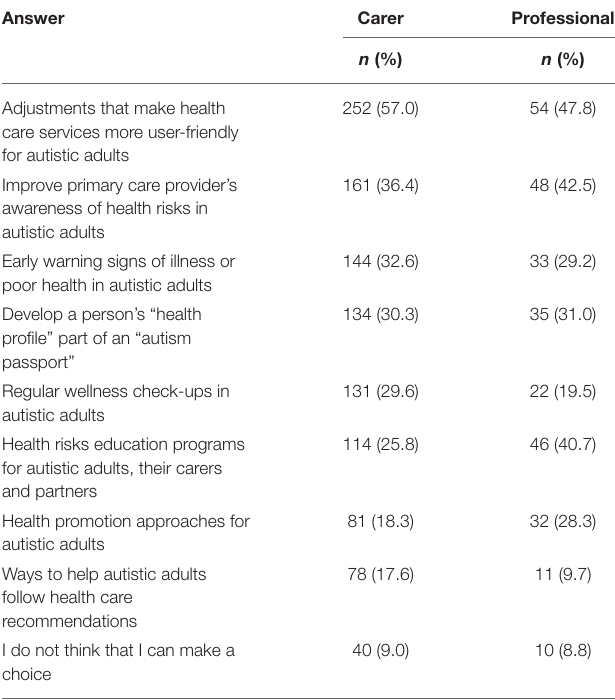
TABLE 4 | Top considerations to promote better health of autistic adults selected by carers and professionals. Answer Carer